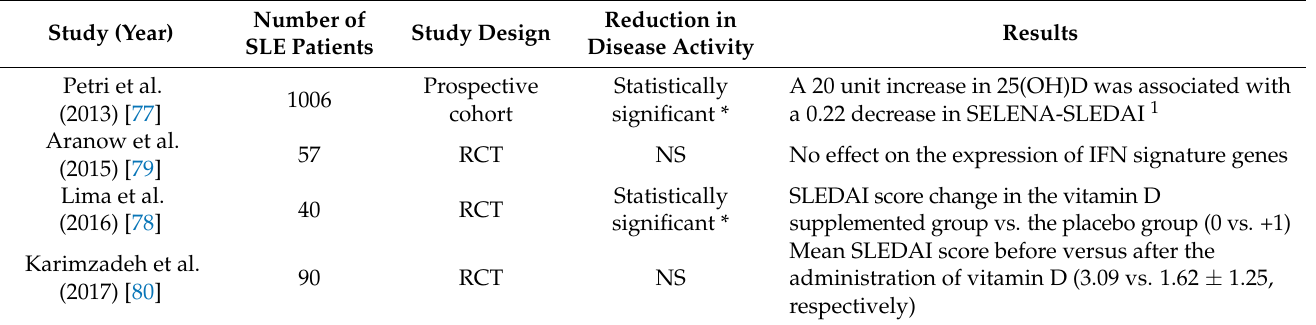
Table 1. Summary of trials on the effects of vitamin D supplementation on disease activity in